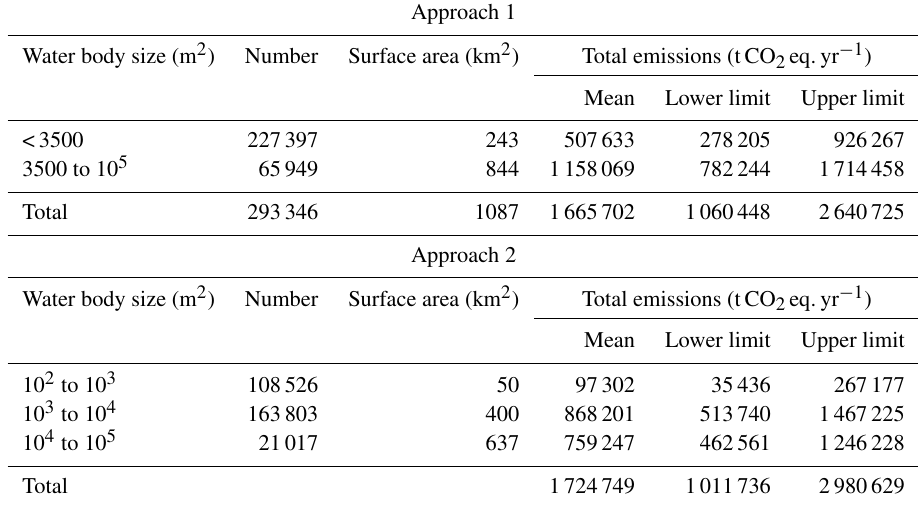
Table 1. Summary of Queensland small water bodies classified using two different relative size classifications. The number of water bodies, corrected surface area of size class and total mean annual emissions. Approach 1: emissions for water bodies less than 3500m 2 were assumed to be stock dams and larger water bodies were assumed to be irrigation dams (Fig. 3a). Approach 2: emissions for GRanD size classes were taken from Fig. 3b. However, weir emissions were omitted as these are not relevant at the regional